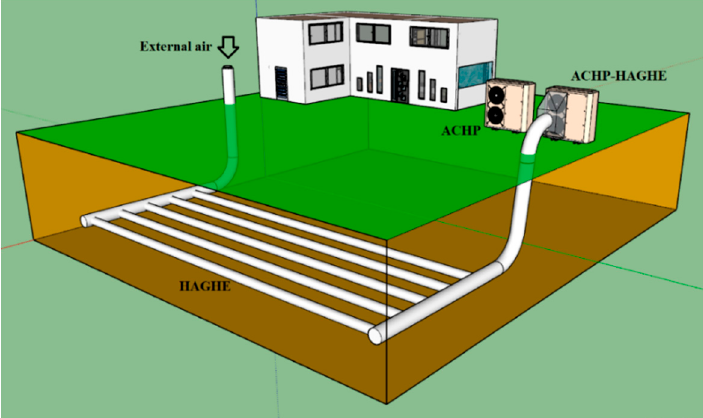
Figure 1. ACHP ‐ HAGHE plant. Figure 1. ACHP-HAGHE